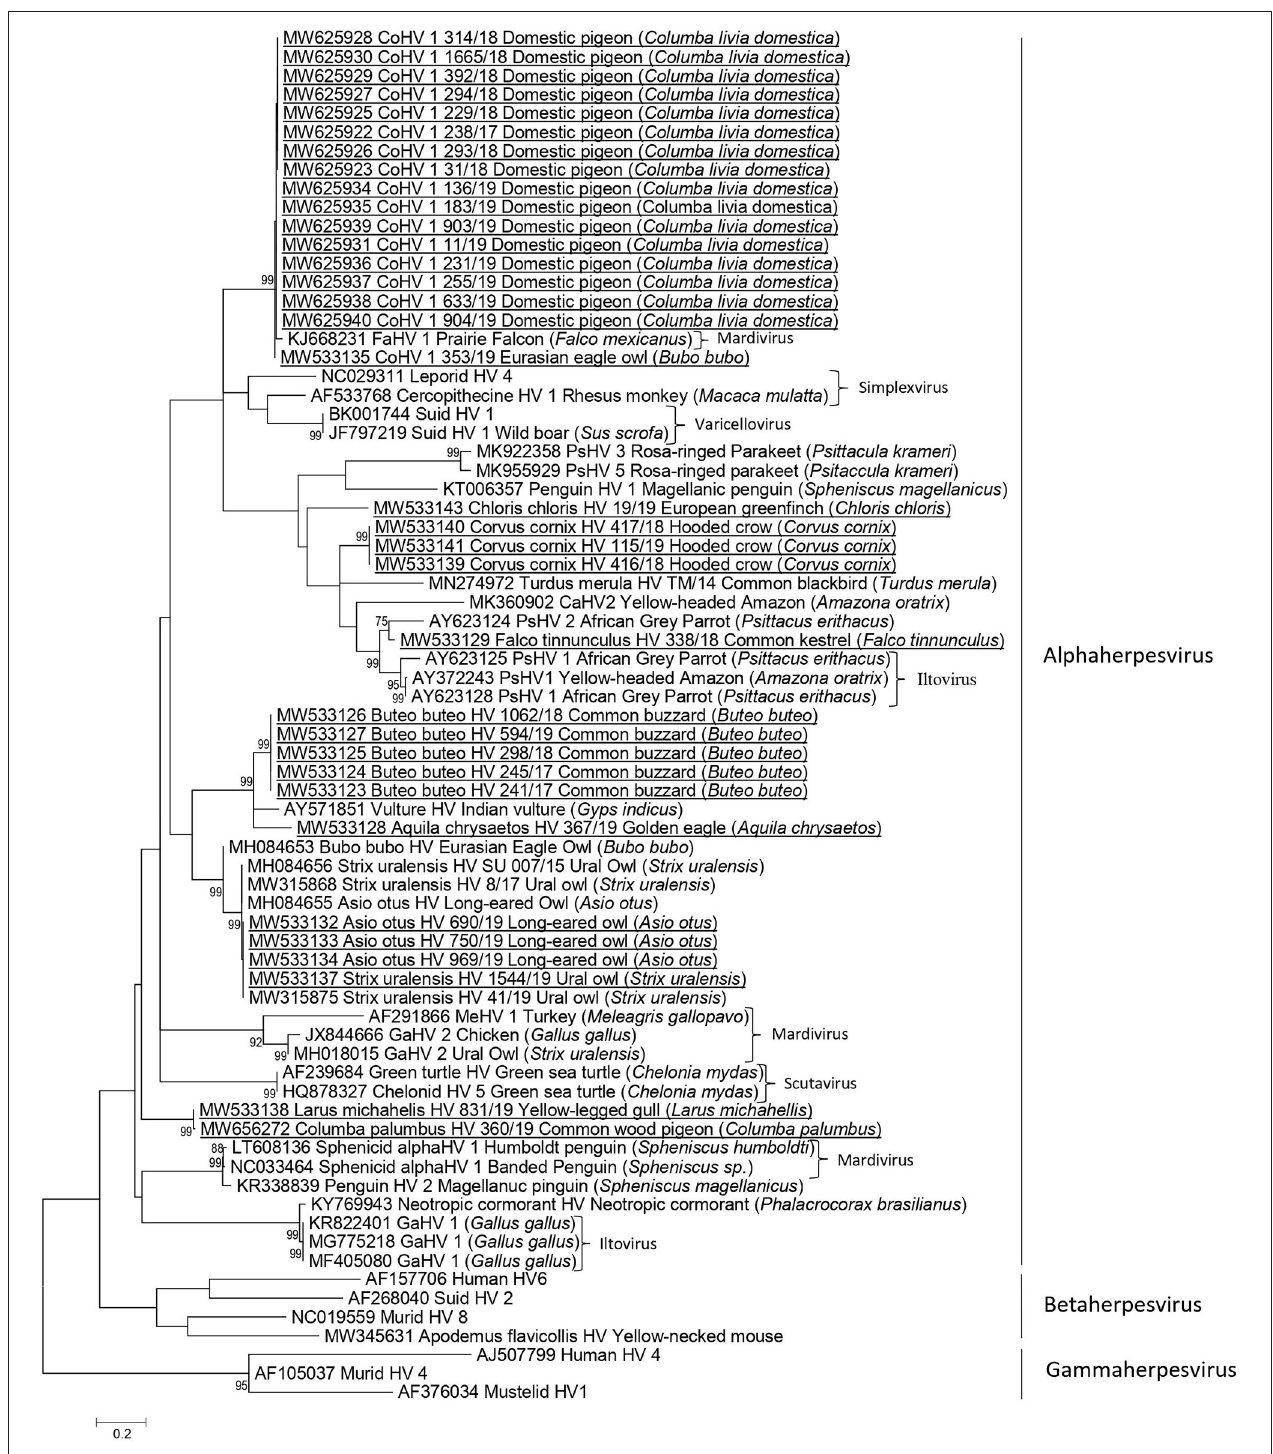
FIGURE 1 | Phylogenetic relationship based on partial DNA polymerase gene nucleotide sequences of herpesviruses from wild birds in Slovenia and other herpesviruses derived from the GenBank database. The scale bar indicates substitutions per site. Nucleotide sequences obtained in the current study are additionally